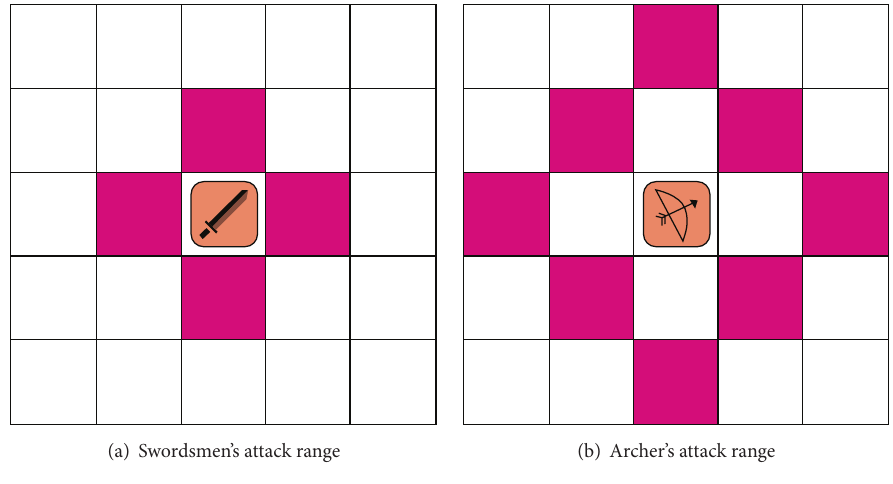
Figure 5: Units’ attack